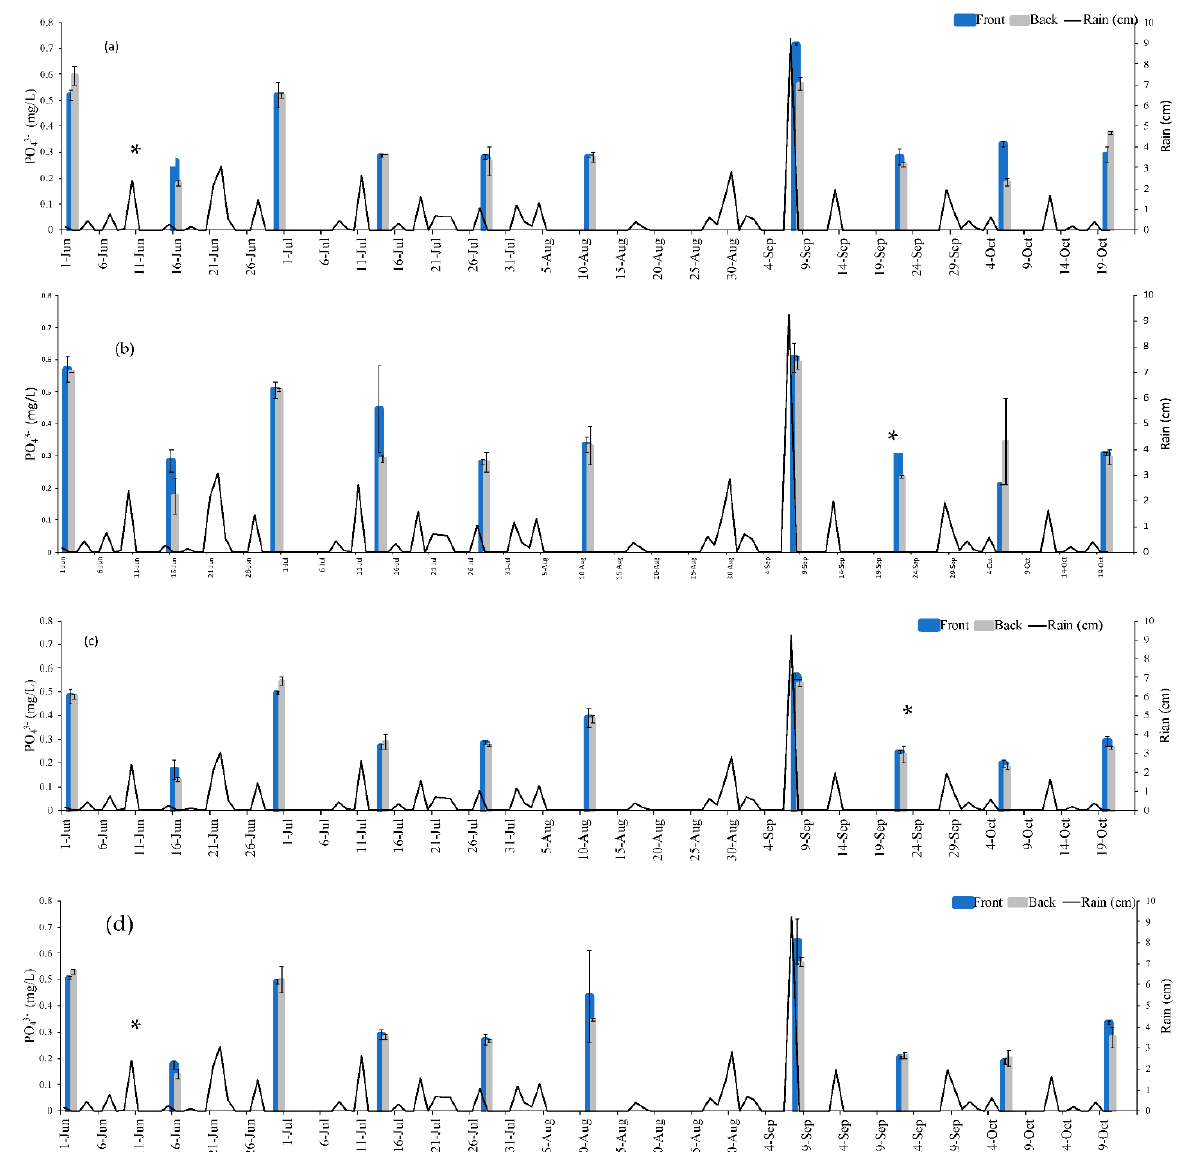
Figure 6. PO 43 − levels immediately in the front and back of the gate during sampling events during 2020. ( a ) Gate 5, ( b ) Gate 6, ( c ) Gate 7, and ( d ) Gate 8. * denotes the date when WTR in cartridges were changed. Error bars are standard deviation of triplicate samples.